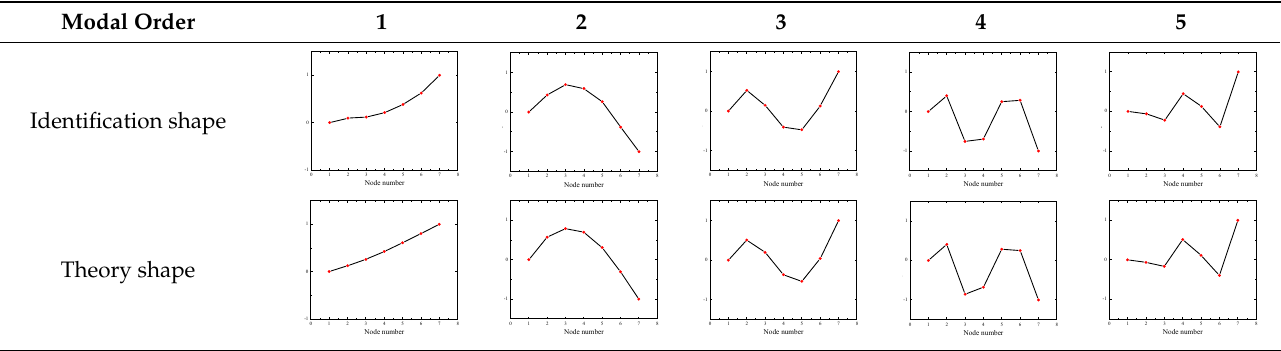
Figure 13. Test versus theoretical frequency response diagram. Table 7. Comparison diagram of identification modes.